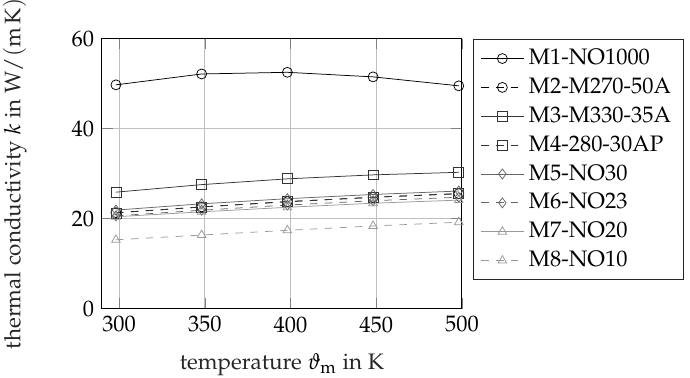
Figure 12. Results of the calculation of the thermal conductivity k calc .